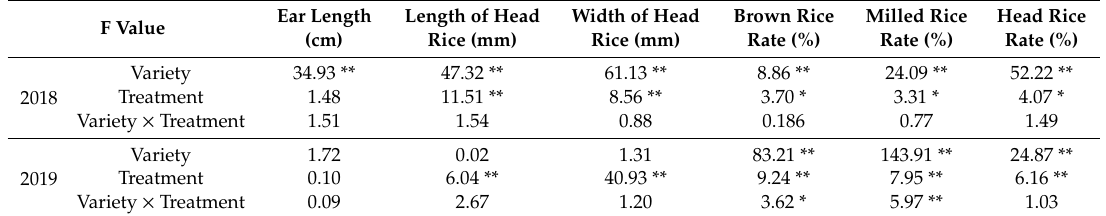
Table 5. Interaction of varieties and treatments on the quality of giant